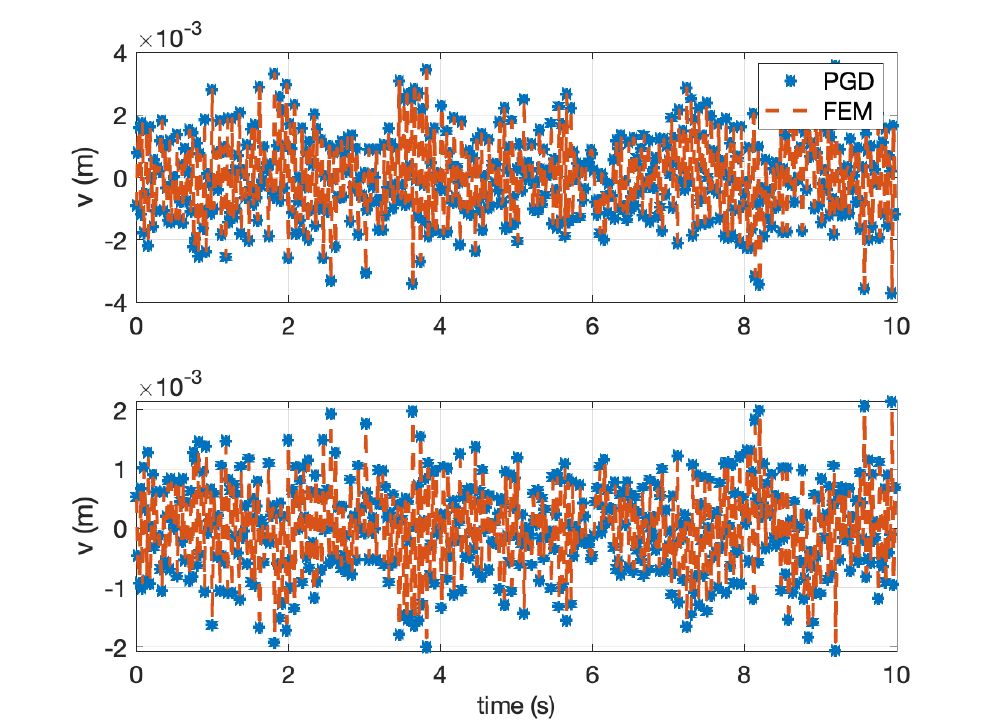
Figure 7. y-component of the displacement at the top of both layers: (top) top layer and (bottom) bottom